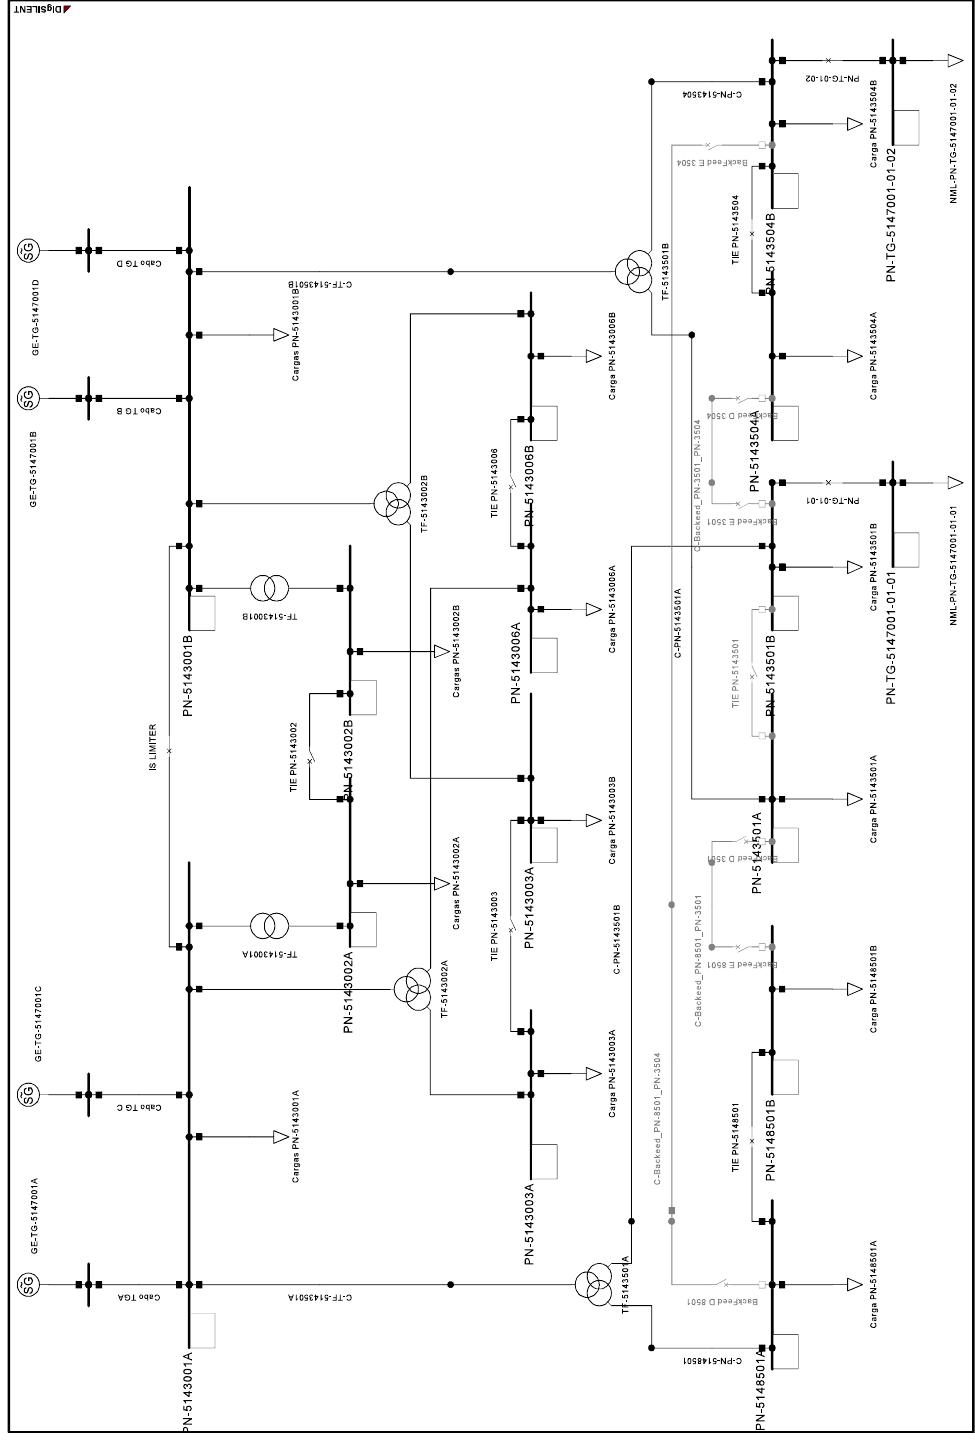
Figure 2. Floating production storage and offloading platform power system (adapted from